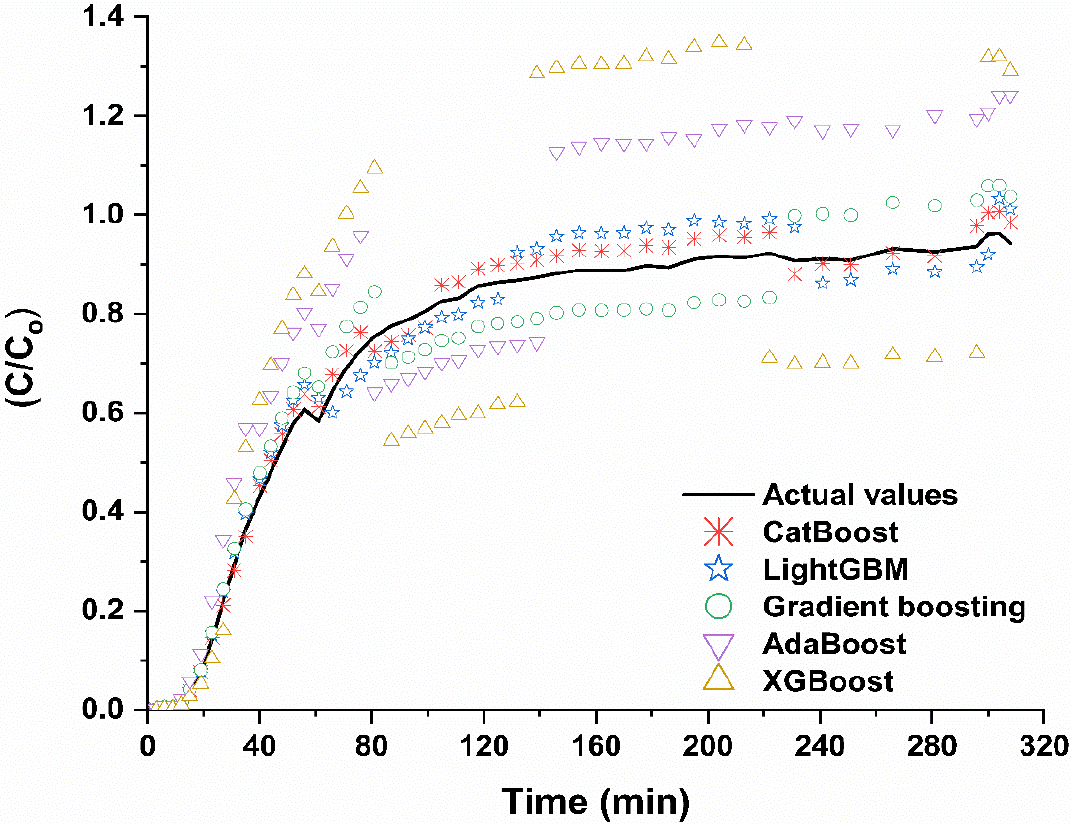
Figure 10. Presentation of the actual values of ( C C (cid:2925) ⁄ ) versus the predicted values at 10 − 4 initial concentration and 0.01 ionic strength.